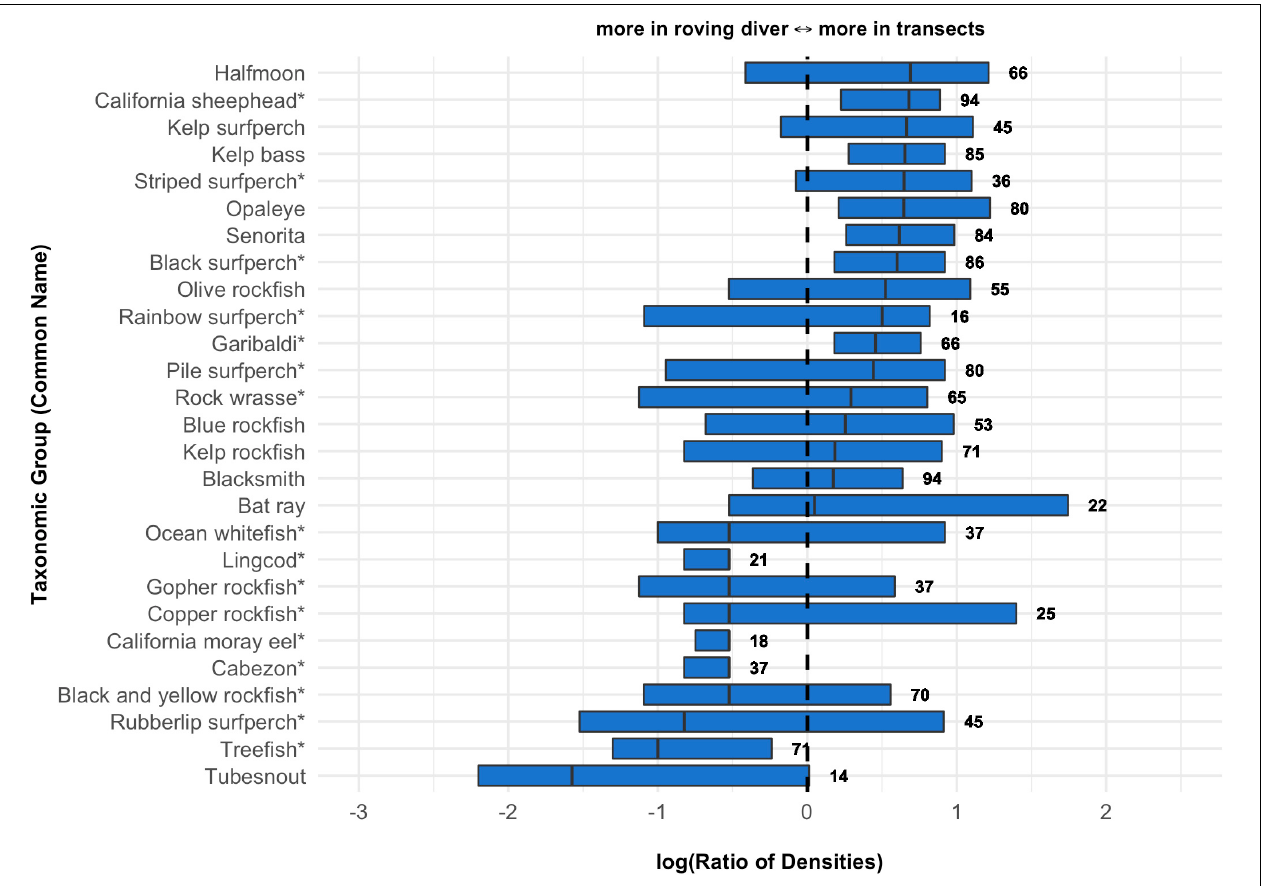
FIGURE 2 | Boxplots showing the log(10) ratios of densities estimated from the KFMP roving diver counts compared to paired sites sampled by PISCO transects. Boxes indicate 25th, 50th, and 75th percentiles. The number of paired samples included in calculations for each taxa is indicated to the right of each bar (only taxa with n ≥ 10 are shown). A star next to the common name indicates more than 90% of individuals are found within 2 m of the bottom in PISCO